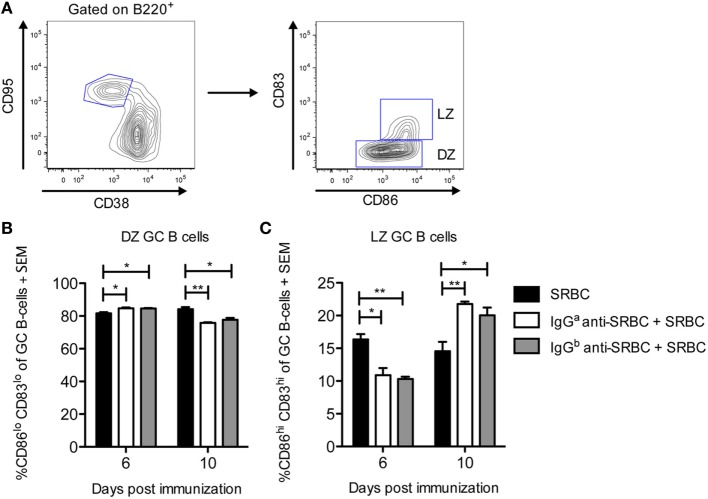
IgG induces a minor shift toward dark zone (DZ) B cells on day 6 and toward light zone (LZ) B cells on day 10. Splenocytes from the same spleens as in Figure 2 were used. On days 6 and 10 after immunization, spleens were harvested for analysis of DZ and LZ germinal center (GC) B-cells by flow cytometry. (A) Representative contour plot showing the gating strategy. (B,C) Quantification of flow cytometry data for groups immunized with 10 µg syngeneic IgGa + 5 × 106 sheep red blood cells (SRBC) (white bars), 10 µg allogeneic IgGb + 5 × 106 SRBC (gray bars), or 5 × 106 SRBC alone (black bars) at indicated time points (n = 3/group). No GC B-cells were detected in unimmunized mice (not shown). Data represent % CD86loCD83lo DZ GC B-cells and % CD86hiCD83hi LZ GC B-cells of B220+CD95hiCD38− GC B-cells. Data are representative of three independent experiments/IgG allotype (ns, p > 0.05; *p < 0.05; **p < 0.01; ***p < 0.001).